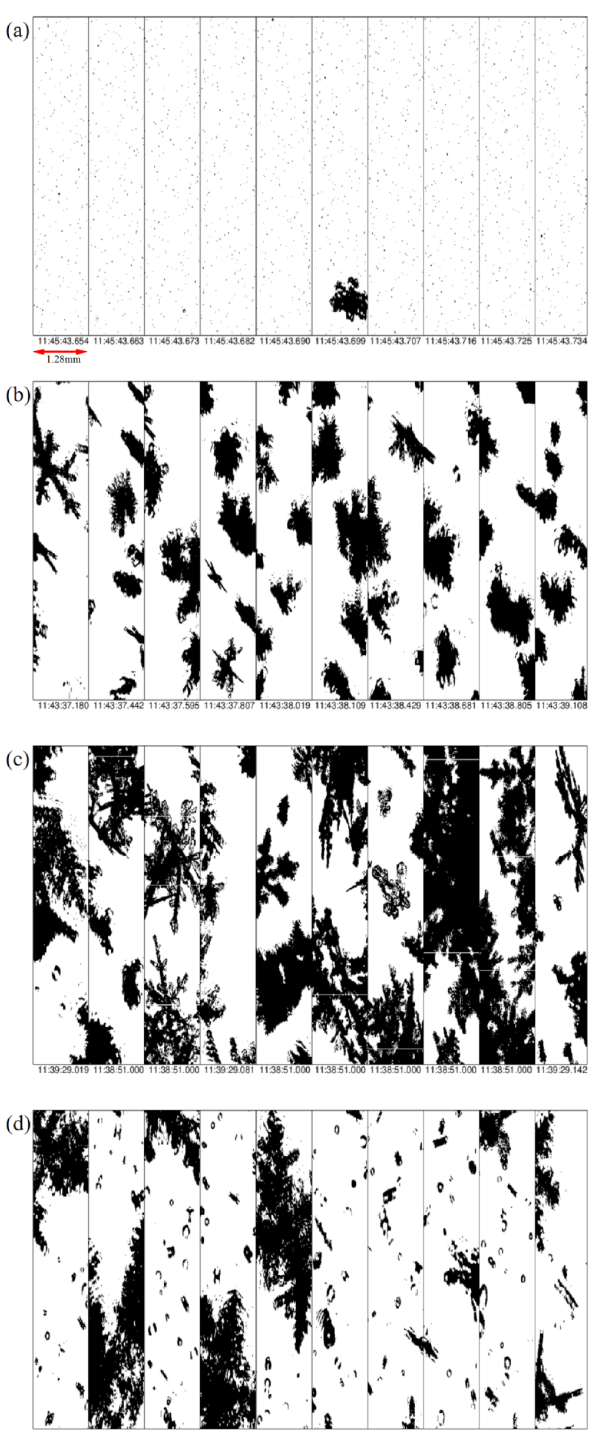
Figure 5. Images from the 2D-S cloud probe from spring case 2 for (a) cloud top during B1, (b) profiled ascent during B2, (c) dendritic ice in the cloud base region during B2, and (d) columnar ice above the sea surface during